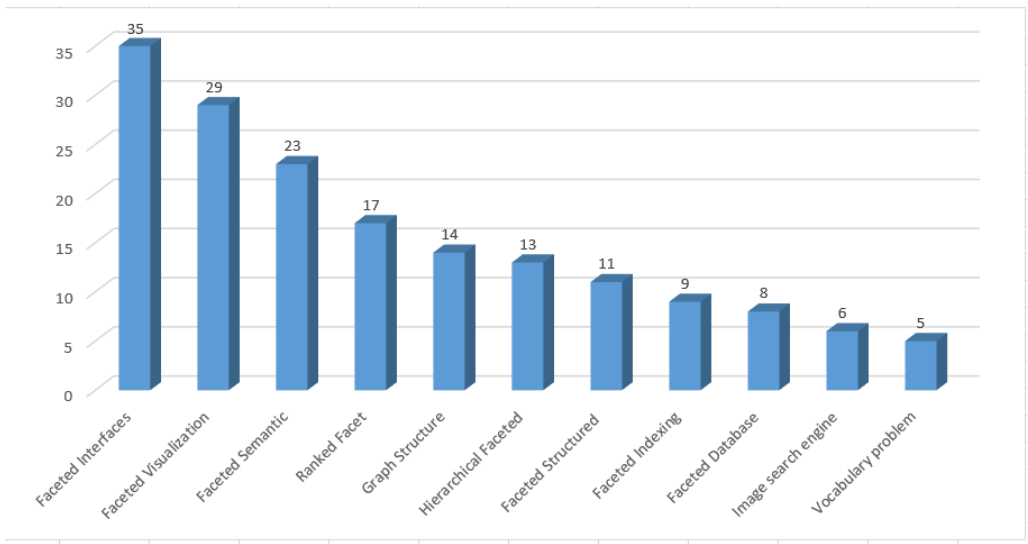
Figure 9. Topics related to faceted search based on information filtering.